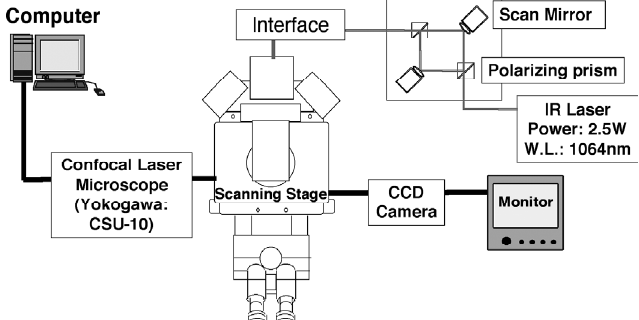
Fig. 1 Schematic diagram of the laser manipulation system in this study. Infra-red laser, the power is 2.5W and the wave length is 1064nm, is used as the laser source. The position of the laser spot can be monitored with a CCD camera which is sensitive to IR and connected to the right side port of the microscope, and controlled with scan mirrors. Fluorescence images were taken with the confocal microscope unit and loaded into the